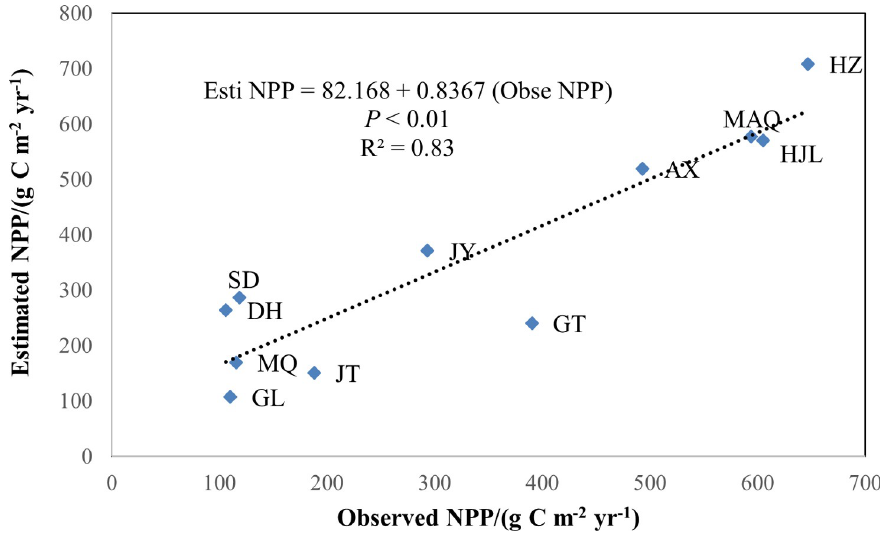
Fig 3. Comparison of estimated and observed NPP in Gansu, China from 1982 to